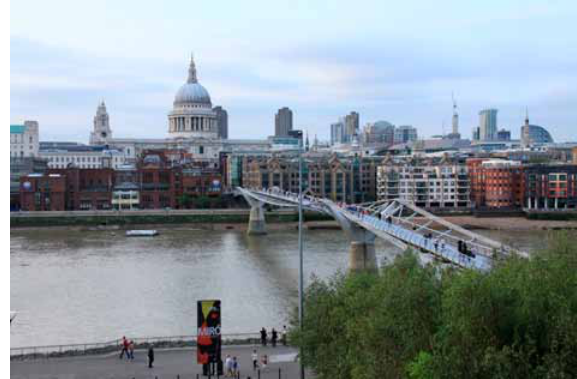
fig.11. Silhouette of rome without modern